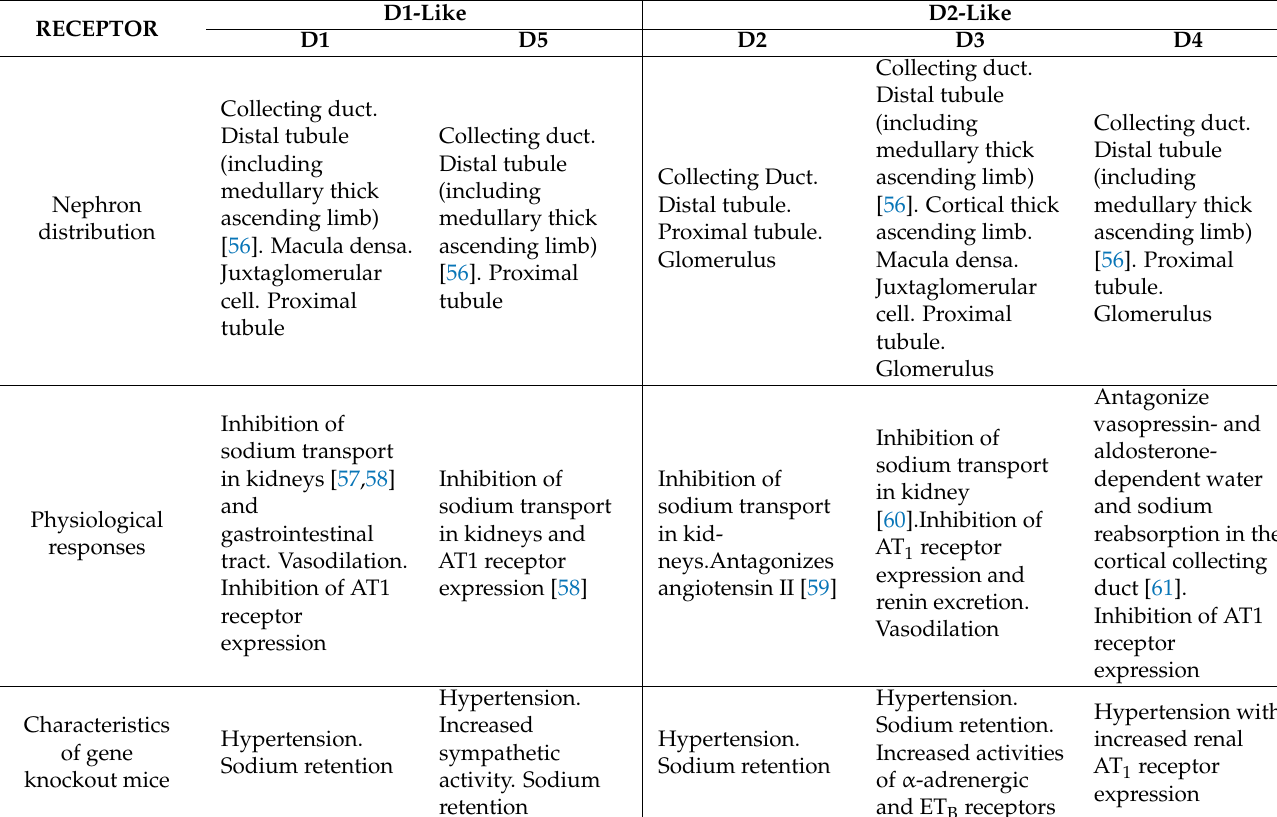
Table 2. Distribution, physiological response, and associated pathology in the renal dopaminergic